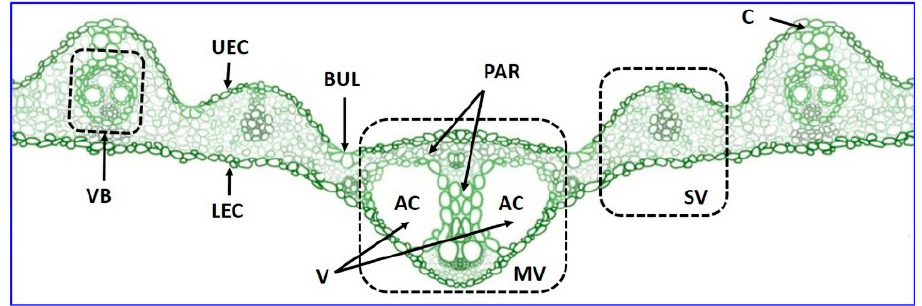
Figure 1. The schematic diagram of rice leaf structural formation. Note the use of the following acronyms in the figure: AC: aerenchyma, BUL: bulliform cells, C: collenchyma, L: lower epidermis cells, MV: mid-vein, PAR: parenchyma, SV: small vein, U: upper epidermis cells, V: vacuum regions, VB: vascular bundle.